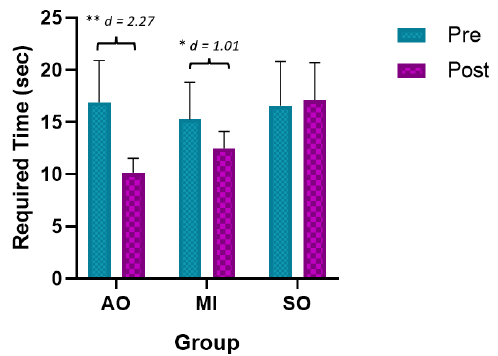
Figure 3. Main results for required time. * p < 0.05; ** p < 0.01; MIP: motor imagery practice; AOP: action observation practice; SO: Sham observation . Table 2. Main results obtained.